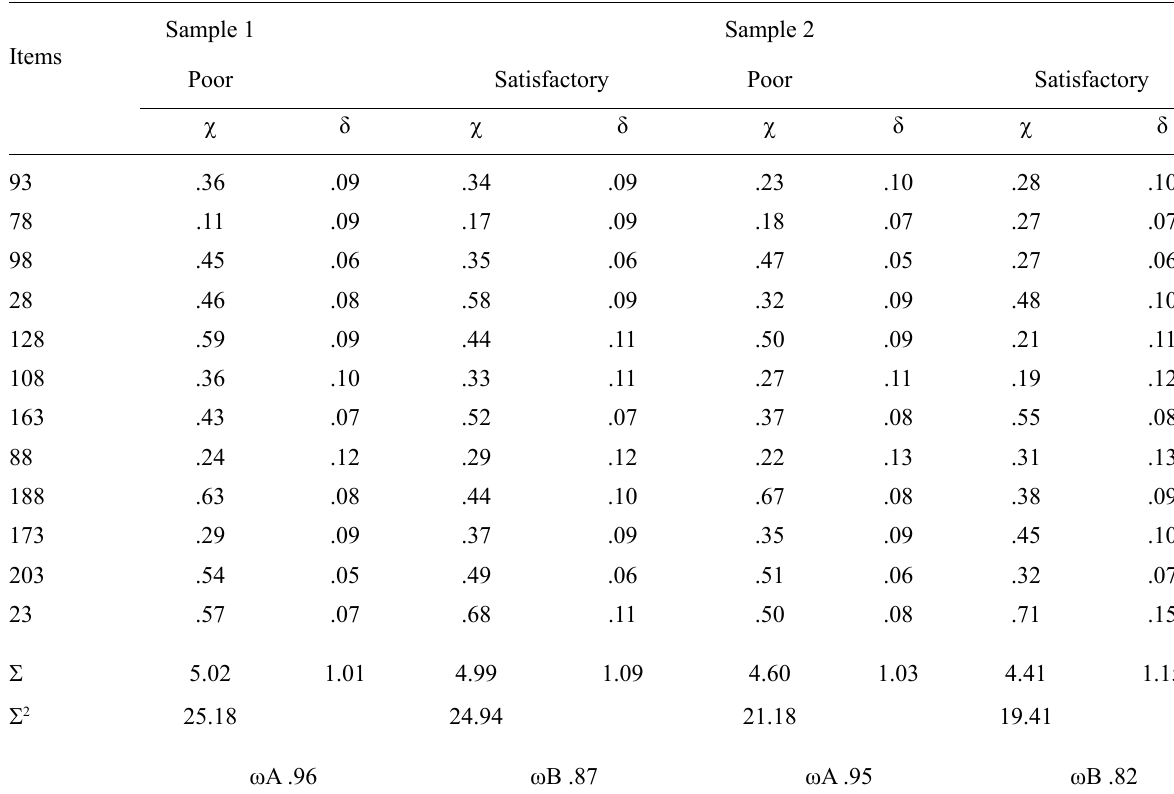
Completely Standardized MLE Parameter Estimates for Poor and Satisfactory Fitting Single-Factor Models: Openness to